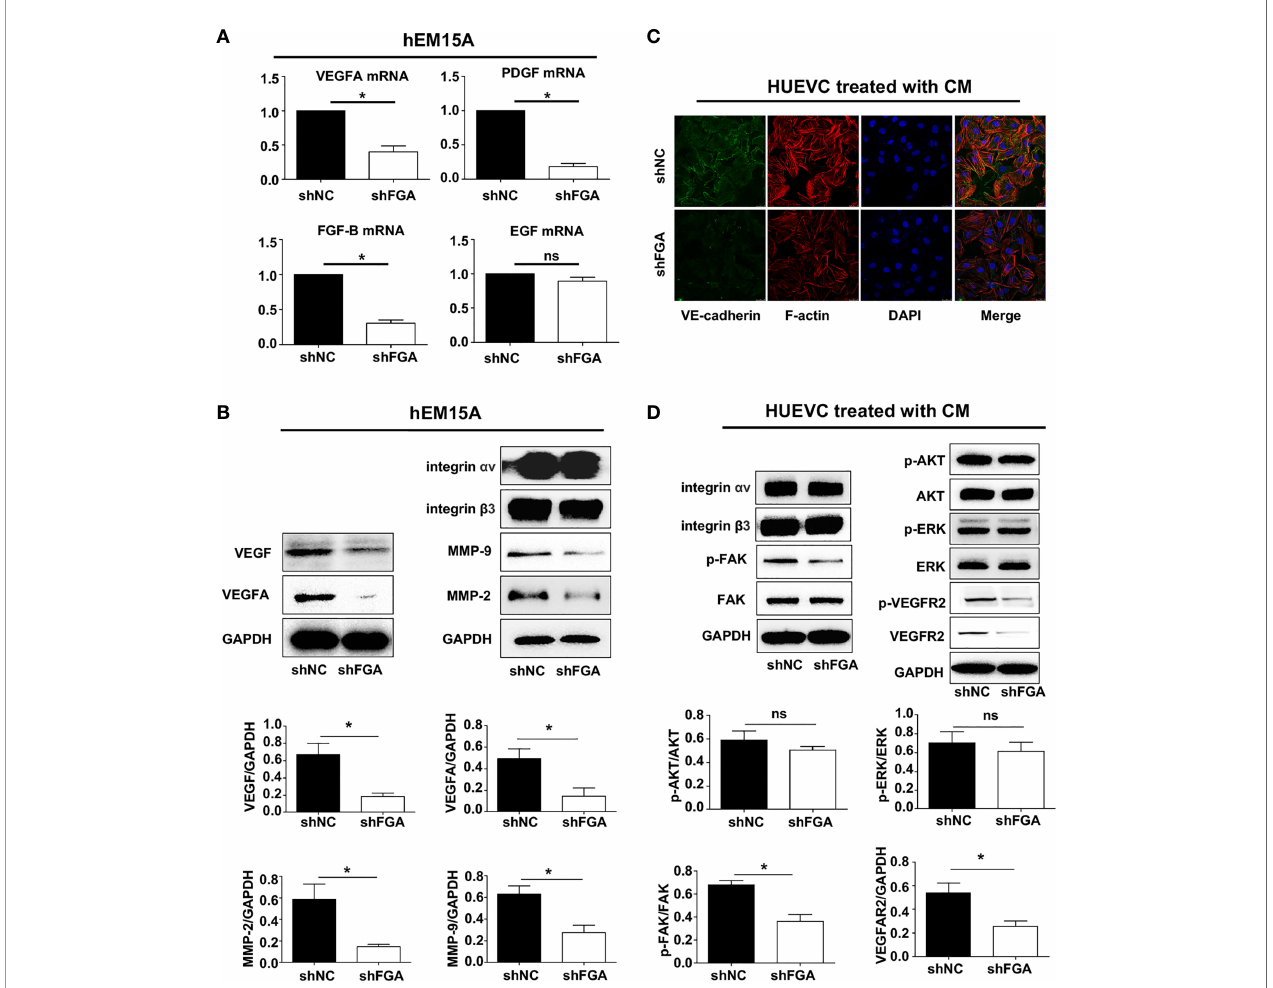
FIGURE 5 | The speci fi c mechanism of FGA on angiogenesis in endometriosis. (A) The relative mRNA expression of VEGFA, PDGF, FGF-B and EGF in hEM15A after FGA knockdown by shFGA compared with control group (shNC) was detected by RT-PCR. (B) The protein expression of VEGFA, VEGF, MMP-2 and MMP-9 in hEM15A with FGA knockdown was detected by western blotting. (C) Representative immuno fl uorescence image of HUVECs treated with CM of hEM15A shNC and hEM15A shFGA cells for 24h (green, VE-cadherin; red, F-actin; blue, DAPI-labeled nuclei). (D) Western blotting analysis showing protein levels of integrin a v, integrin b 3 and the signalling pathway of VEGFR2, FAK, AKT, ERK in HUVECs treated with CM of hEM15A shNC and hEM15A shFGA cells for 24h. * P <0.05, ns, not signi fi cant, P ≥